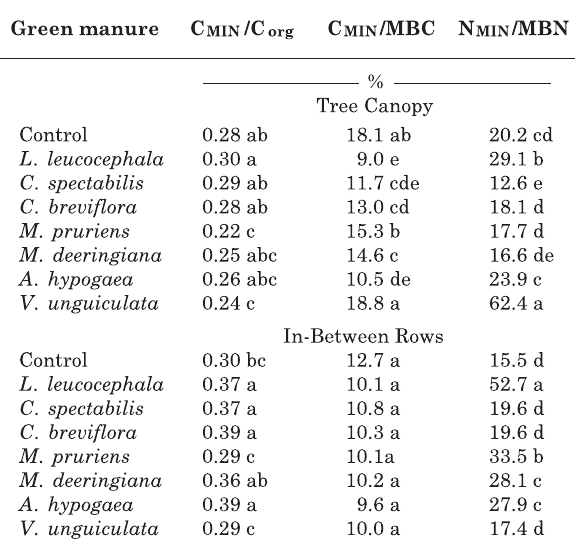
) to MIN ) to Figure 1. Relationship of C mineralization (C MIN soil organic carbon (a), to microbial biomass C (MBC) (b) and to N mineralization (N under the tree canopy and in-between rows. * and ** Significant at 5 and 1 %,